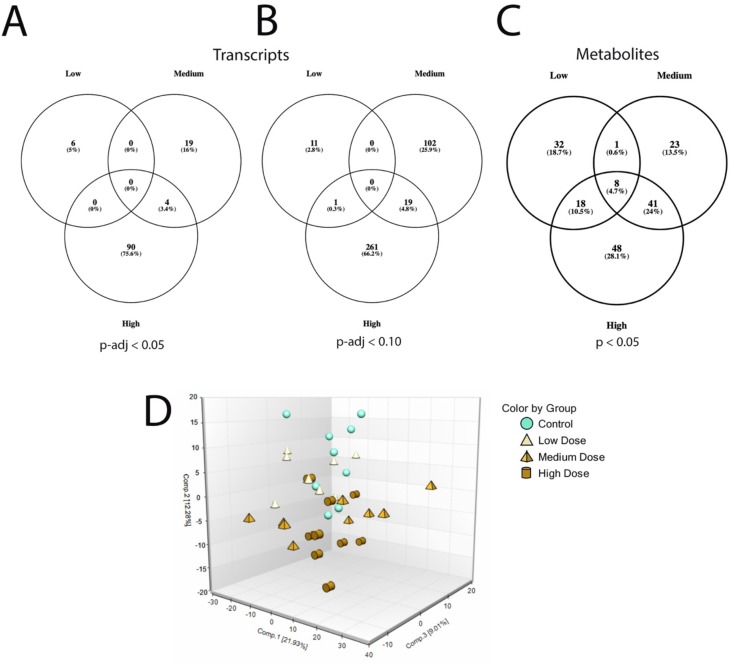
Differentially expressed transcripts and metabolites in the low-, medium-, and high-treatment groups in liver of Atlantic cod exposed to chlorpyrifos-methyl for 30 days. (A) Venn diagram of transcripts p-adj < 0.05, (B) Venn diagram of transcripts p-adj < 0.10), and (C) Venn diagram of metabolites p < 0.05. (D) Principal component analysis plot of liver metabolites.